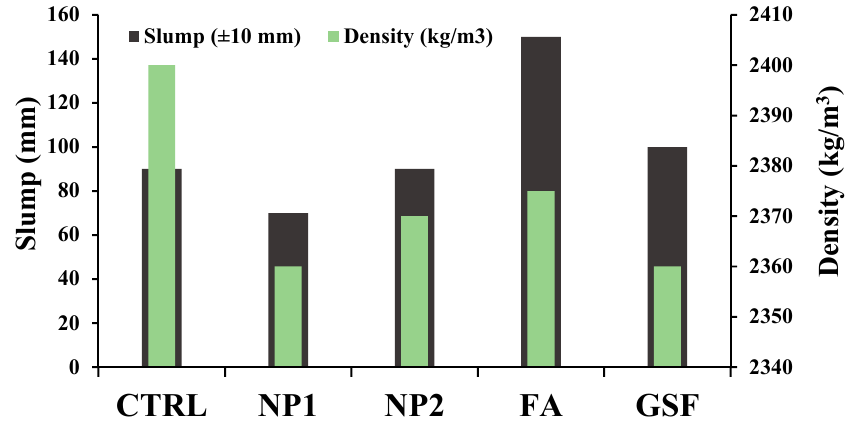
Figure 15. Fresh properties of concrete.